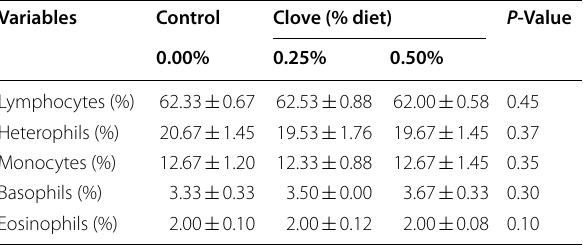
Table 3 White blood cell differentials of laying hens fed diets Syzygium aromaticum leaf meal